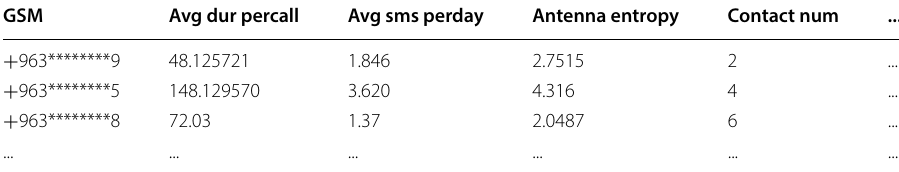
Table 2 Sample of behavioral extracted